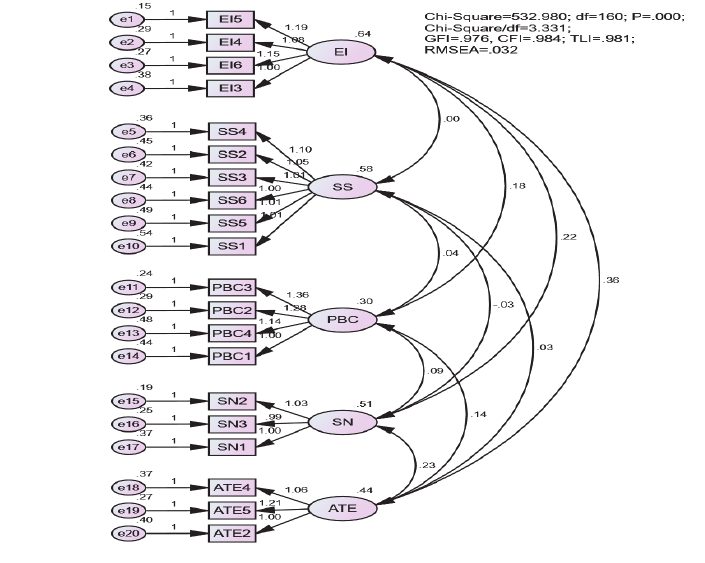
Fig. 2. The results of confirmatory factor analysis (unstandardized estimates) Source: Authors’ elaborations based on research